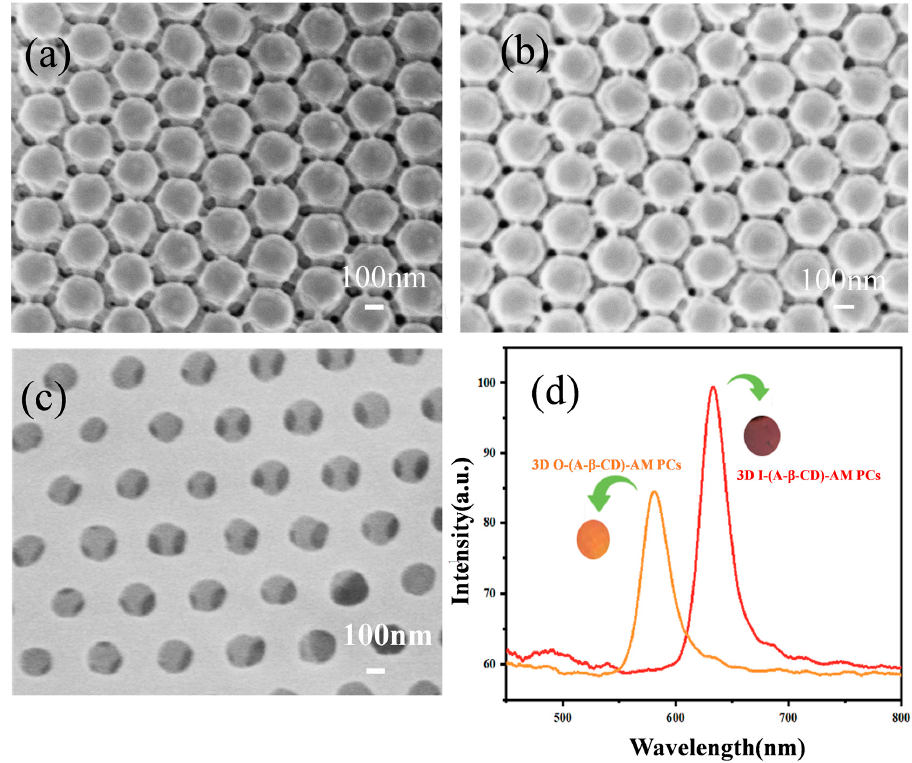
Figure 4. SEM images of 3D O-(A- β -CD)-AM PCs with PMMA of ( a ) 225 nm; ( b ) 240 nm; ( c ) 3D O- (A- β -CD)-AM PCs; ( d ) the reflection peak of 3D O-(A- β -CD)-AM PC and 3D I-(A- β -CD)-AM PC.